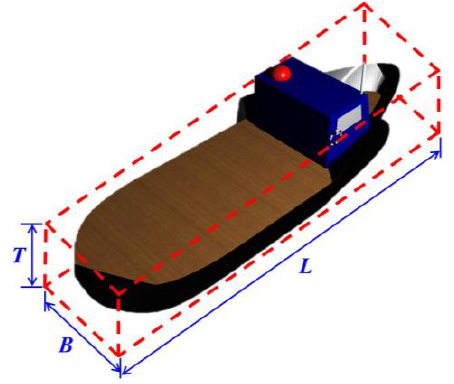
Figure 2. Principal dimensions of controlled AUSV. Table 1. Dimensions of the autonomous unmanned surface vessels (AUSV) illustrated in Figure 2.